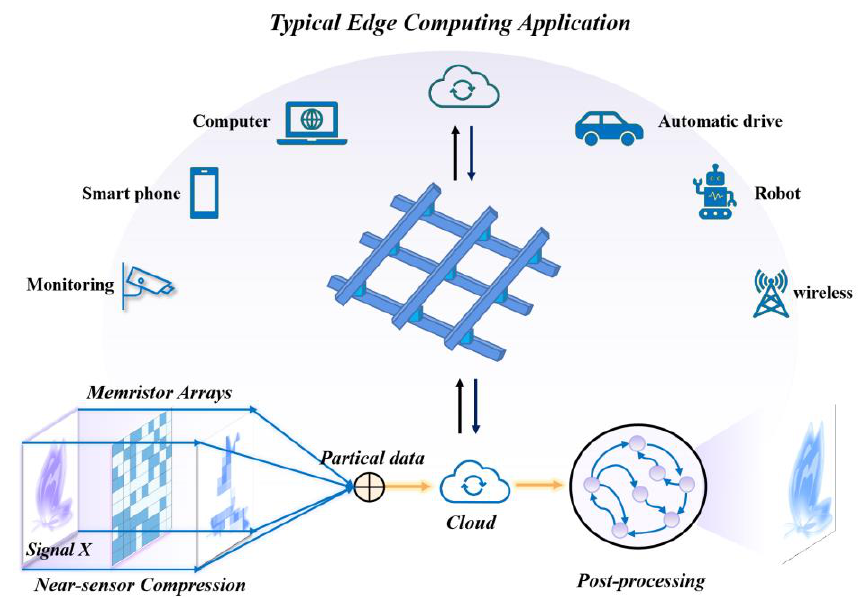
Figure 1. Illustration of the compressed sensing based on memristor crossbar arrays for typical edge computing application. Reproduced with permission. [2] Copyright 2022, Wiley−VCH.